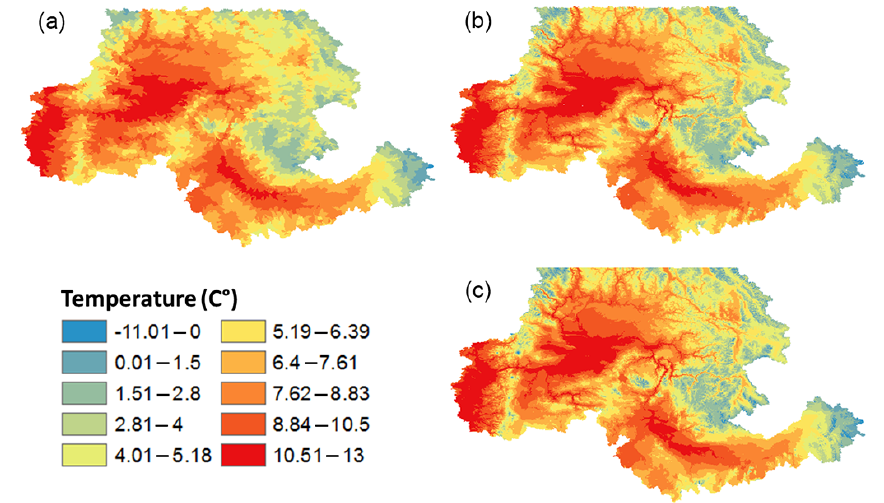
Figure 14. Same as Fig. 13, but for temperature.